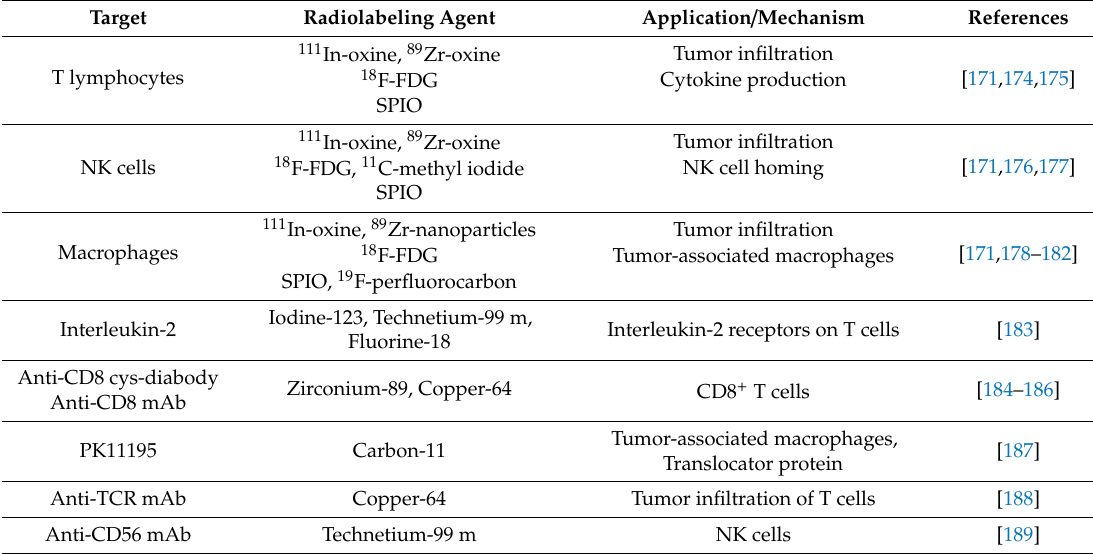
Table 3. Potential Radiopharmaceuticals to Image Immune Cells and Cell